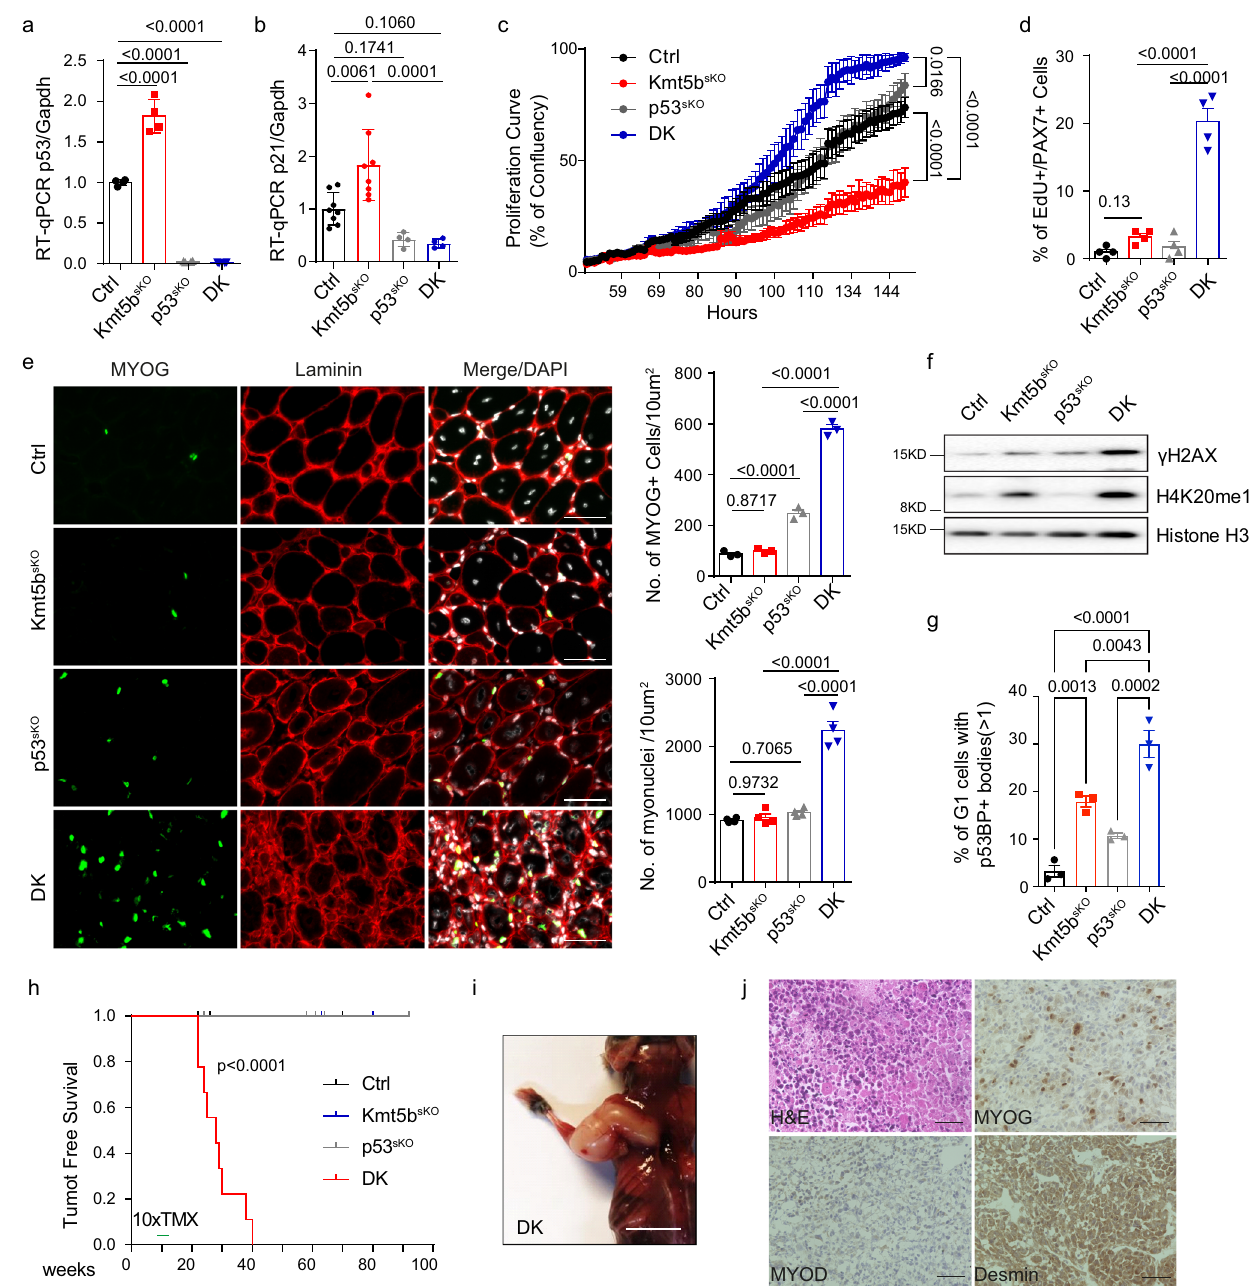
Fig.6|Abrogationofcellularsenescenceandcellcyclearrestbyinactivationof p53 in Kmt5b sKO MuSCscausesrapidformationofrhabdomyosarcomas.a , b RT- qPCR analysis of p53 ( a ) and p21 ( b ) expression in Ctrl , Kmt5b sKO , p53 sKO and DK MuSCs ( n =3 mice). Gapdh served as reference gene. c Proliferation of Ctrl , Kmt5b sKO , p53 sKO and DK MuSCs assessed by time lapse imaging ( n =3 mice). Sta- tistical signi fi cance at the last time point was calculated by One-way ANOVA. d Quanti fi cation of immuno fl uorescence analysis showing the presence of EdU + /PAX7 + MuSCs in TA muscles from Ctrl , Kmt5b sKO , p53 sKO and DK littermates after 5 days of EdU administration ( n =4). e Immuno fl uorescence staining for MYOG and lamininonTAmuscle cryosections from different mutant mice10 days after CTX injection. Scale bar: 50 µ m. Numbers of MYOG + cells (upper right panel, n =3 mice, each group) and myonuclei (lower right panel, n =4 mice for each